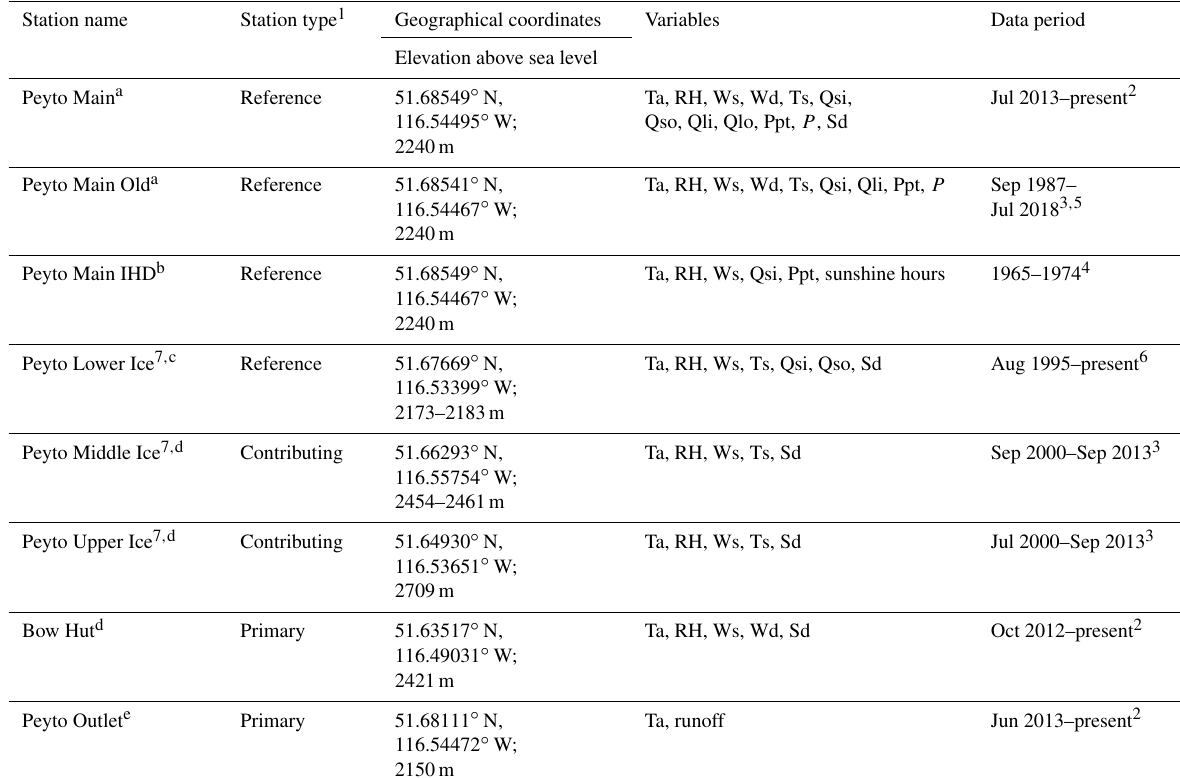
Table 1. CryoNet station data.